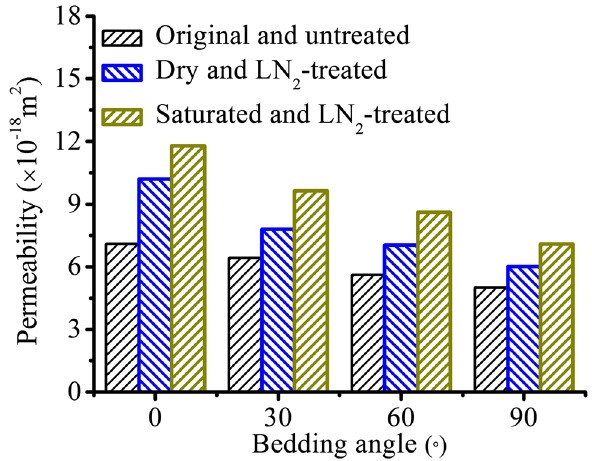
Fig. 5 Brazilian tensile strength of different bedding shales before 2 and after LN 2